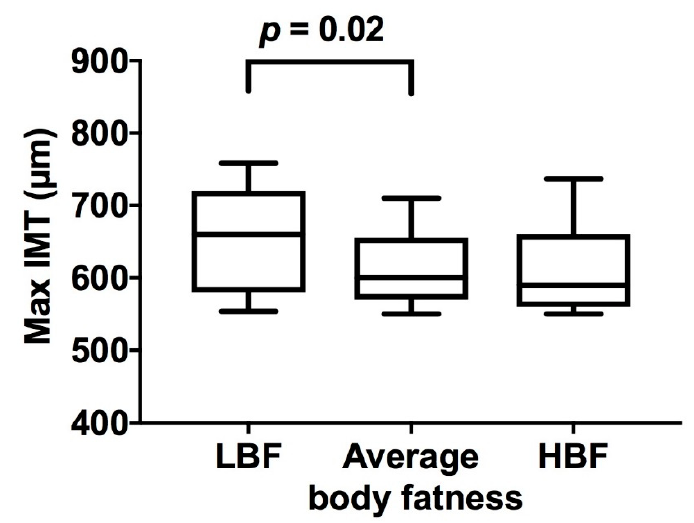
Figure 1. Effect of infant body fatness on maximum aortic intima-media thickness. LBF: low body fat ( ≤ 10th BF%); HBF: high body fat (>90th BF%); average body fatness (>25th to ≤ 75th BF%). Box, line, and error bars represent 10th, 25th, 50th (median), 75th and 90th percentiles.